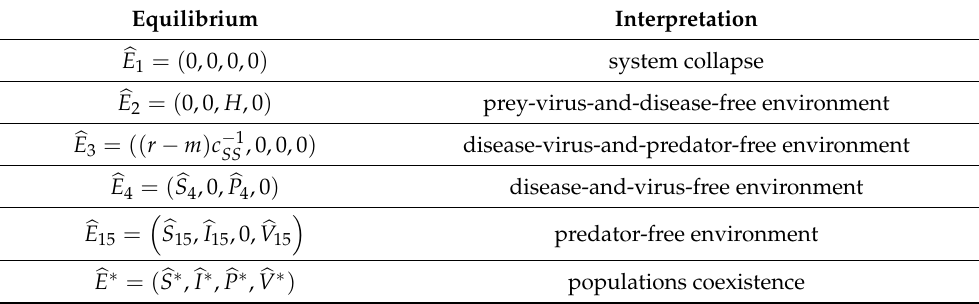
Table 4. Equilibria (cid:98) E k = ( (cid:98) S k , (cid:98) I k , (cid:98) P k , (cid:98) V k ) of (11) and their ecological interpretation. Equilibrium